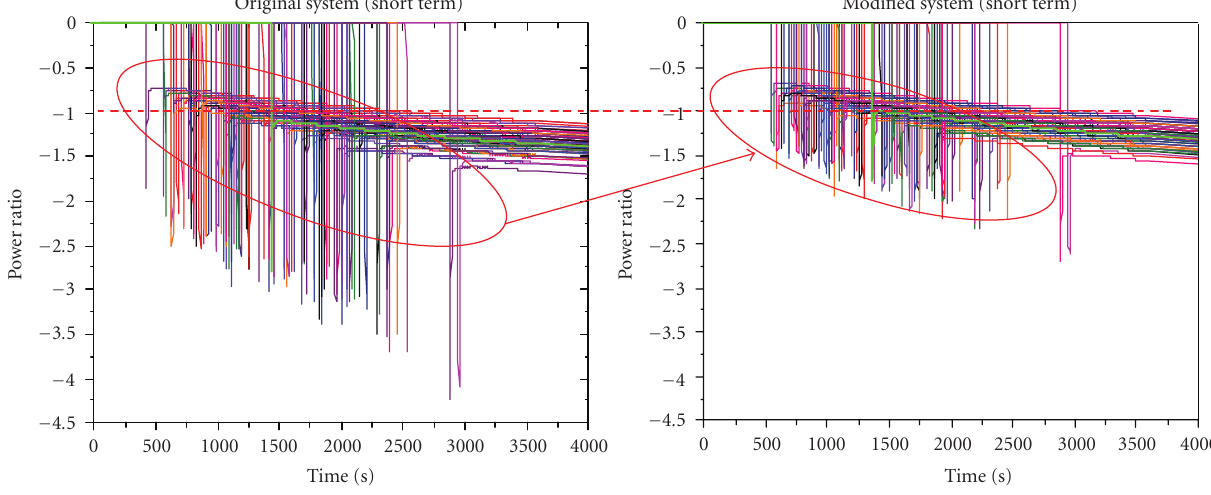
Figure 15: Power ratio comparison between the original and the modified